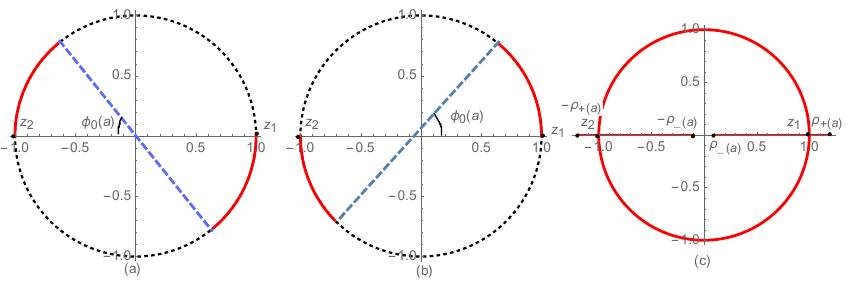
Figure 17. The three image of the physical cuts corresponding to the three cases (a) 0 < a < µ (b) µ and (c) a ≤ 0 < a < 2 µ 3 3 3